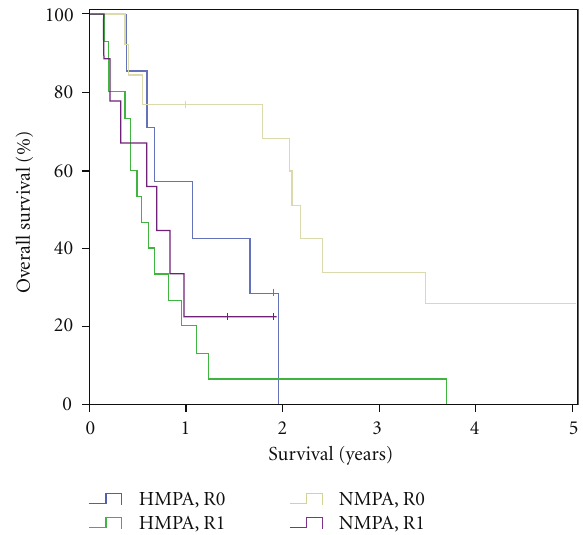
Figure 2: Patient survival in regards of surgical radicality (R0, R1): HMPA versus NMPA.